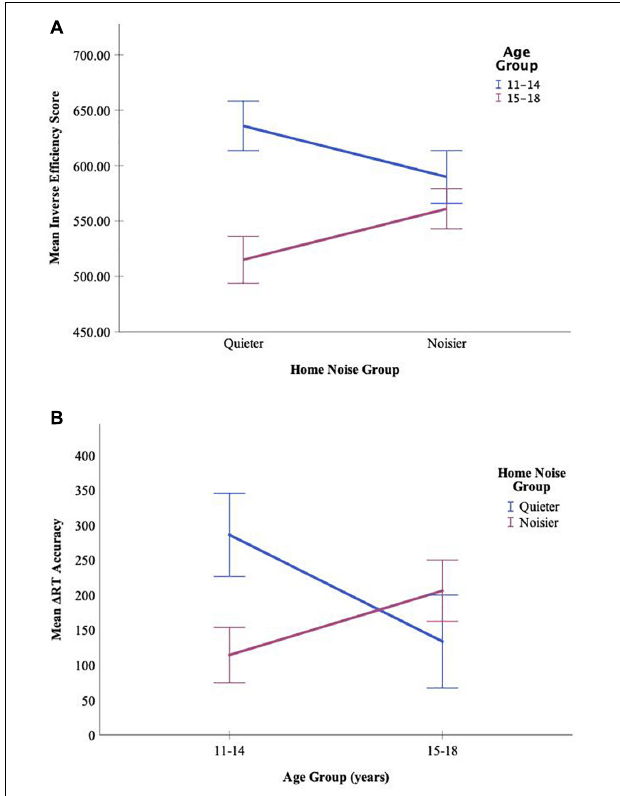
FIGURE 1 | Depiction of the interaction between the age groups and the home noise groups on performance in the Flanker task. Age groups were split into a younger group (ages 11–14) and an older group (ages 15–18), and home noise groups were based on the median split of the home noise scores derived from the Home Environment and Noise Questionnaire ( Mdn = 64.5). The bars in the graph represent standard error. (A) When looking at those participants from quieter homes, older adolescents were significantly more efficient compared to their younger peers, though when looking at those from noisier homes, older participants were no longer performing better than their younger peers. (B) For younger adolescents, those from quieter homes had significantly higher (cid:49) RT Accuracies compared to their peers from noisier homes. There was no difference in performance between the older peers in terms of home noise